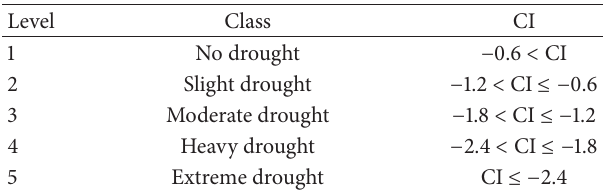
Table 1: Classification standard of the meteorological drought composite index